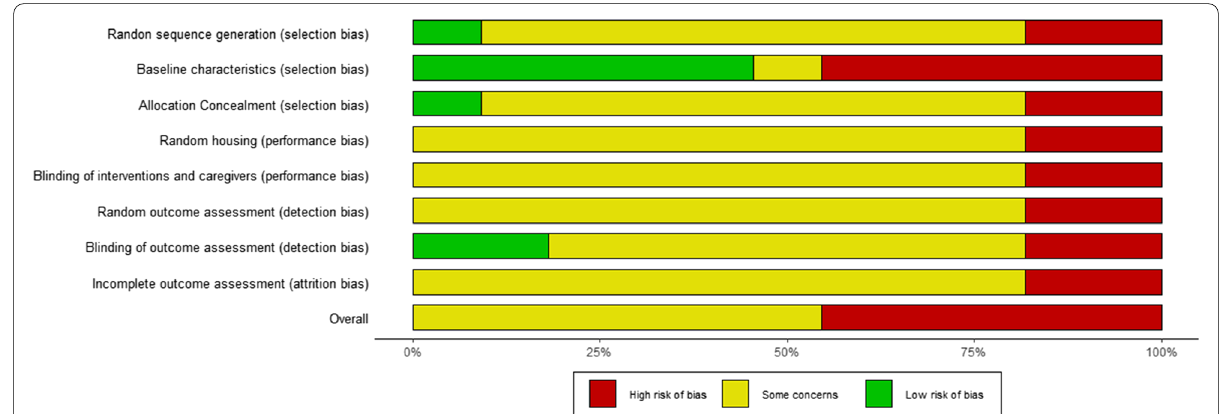
Fig. 3 SYRCLE’s risk of bias assessment for in vivo studies investigating the use of bone marrow-derived products for the treatment of tendon